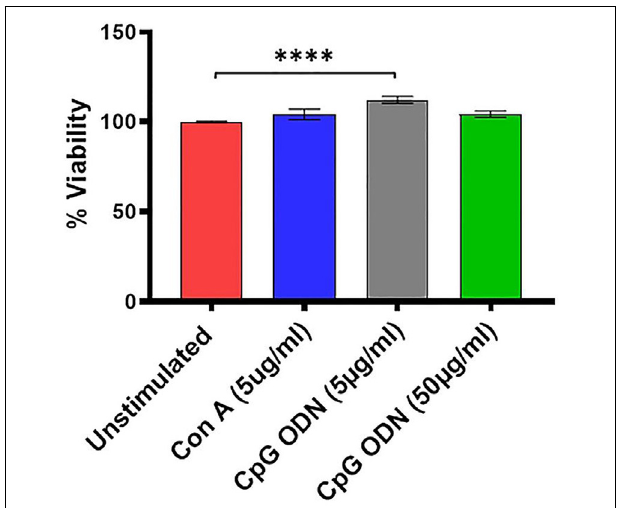
FIGURE 3 | Viability assay. For viability of PBMCs we used a standard MTT proliferation dye reduction assay. PBMCs were cultured in triplicate wells at 1 × 10 5 /well in 96-well round-bottomed plates with 5 µ g/ml and 50 µ g/ml Class C CpG ODN or 5 µ g/ml concanavalin A (Con A) for 96 h at 37 ◦ C. Proliferation responses were measured as optical density (OD) and data are presented as % viability over cells without stimulation. Symbols representing significance are: ∗∗∗∗ p <